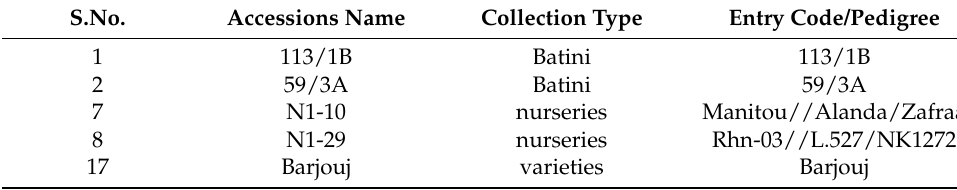
Table 1. The Barley GeneBank accession names and entry number in this study.